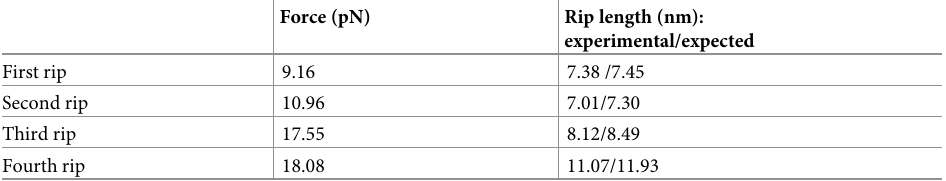
Table 1. Example of RNA rip force and length with 10mM MgCl 2 .